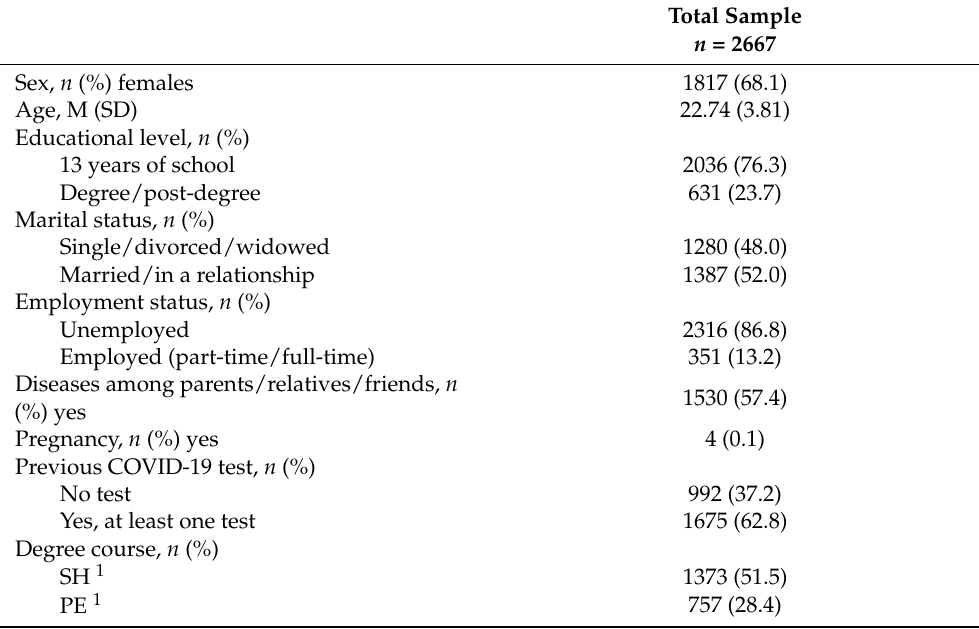
Table 1. Demographics and health-related